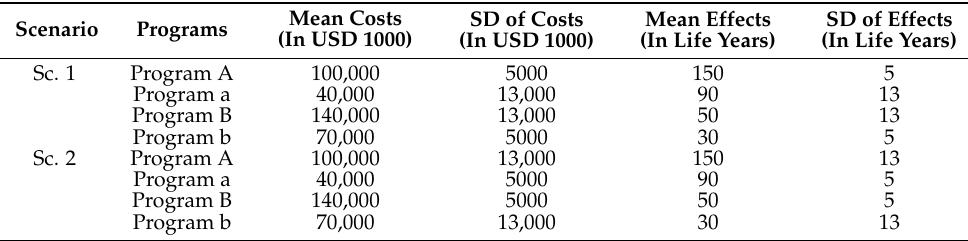
Table 2. Costs and effects of four programs for resource reallocation with decreasing (Scenario 1) and increasing (Scenario 2)